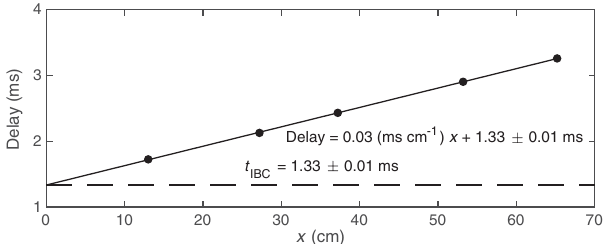
FIG. 4. Estimated time delay of the direct wave at five locations along the waveguide (dots). The line of best fit (solid line) intersects with the ordinate at approximately 1.3 ms, which represents t . The standard error of regression is 0.01 ms or IBC